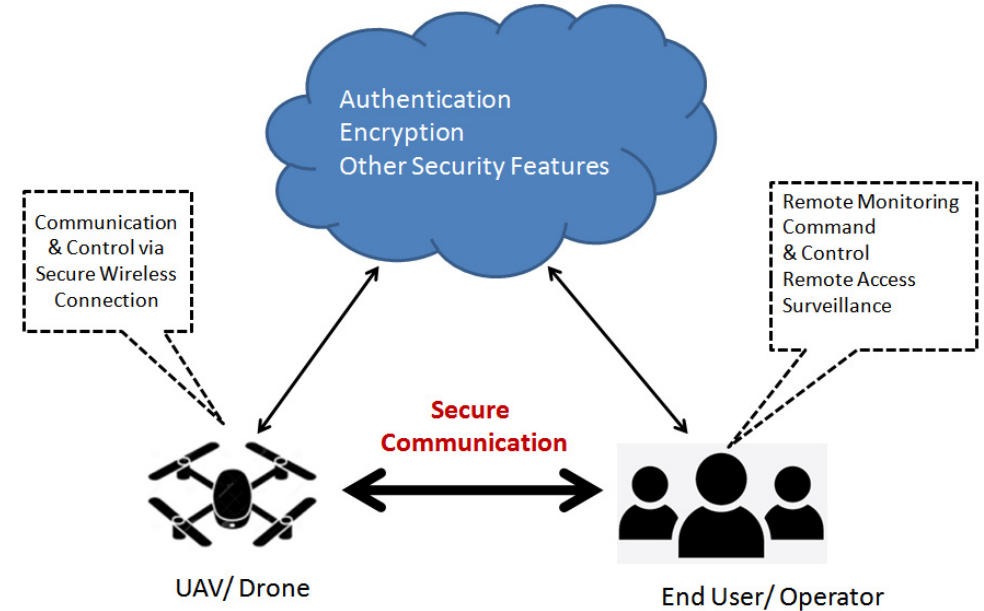
Figure 14. Light weight authentication in UAV systems.